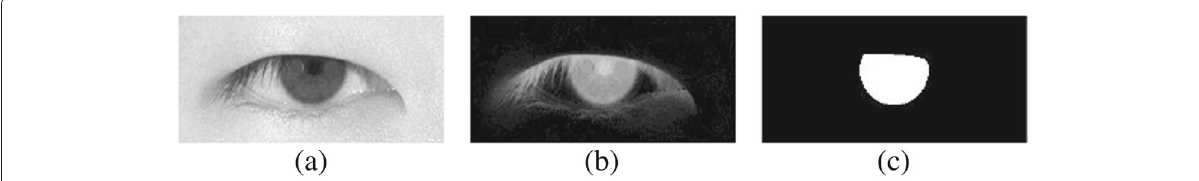
Fig. 5 Precise iris segmentation. Cropped greyscale eye image without specular reflections ( a ), residue of the close-hole operator( b ), Otsu’s thresholding and binarisation after smoothing process and convex hull ( c )